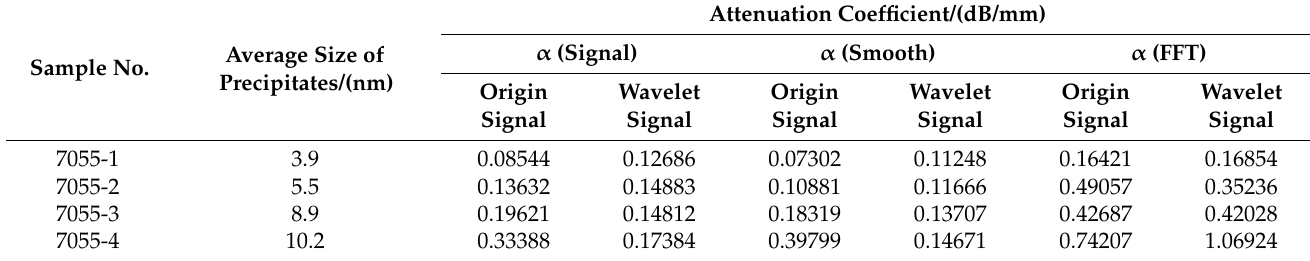
Table 6. Attenuation coefficient of ultrasonic